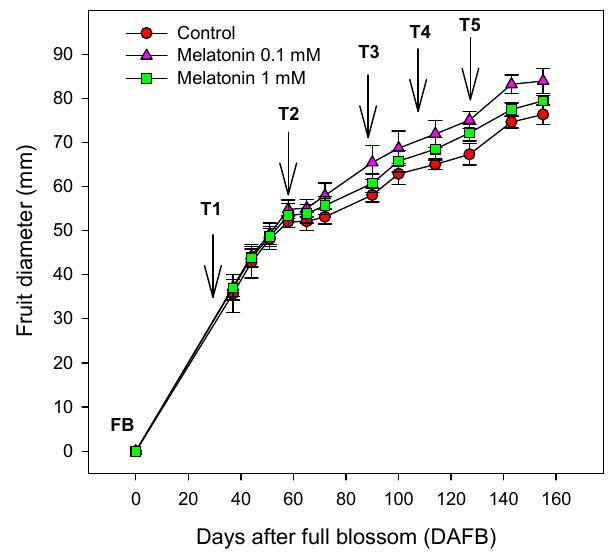
Figure 1. Evolution of fruit size (diameter) during pomegranate development from full blossom (FB) to harvest, in fruit from control and 0.1 or 1 mM melatonin-treated trees. T1–T5 represent the day of treatment. Data are the mean ± SE. Table 1. Data for yield (kg tree − 1 and number of fruit tree − 1 ), and fruit weight in control and melatonin-treated pomegranate trees (0.1 and 1 mM) at two harvest dates (1 and 2). Year 2017.